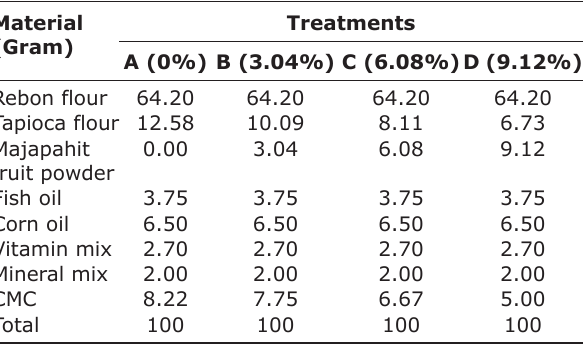
Table-2: Litopenaeus vannamei feed formula trial. Material (Gram)